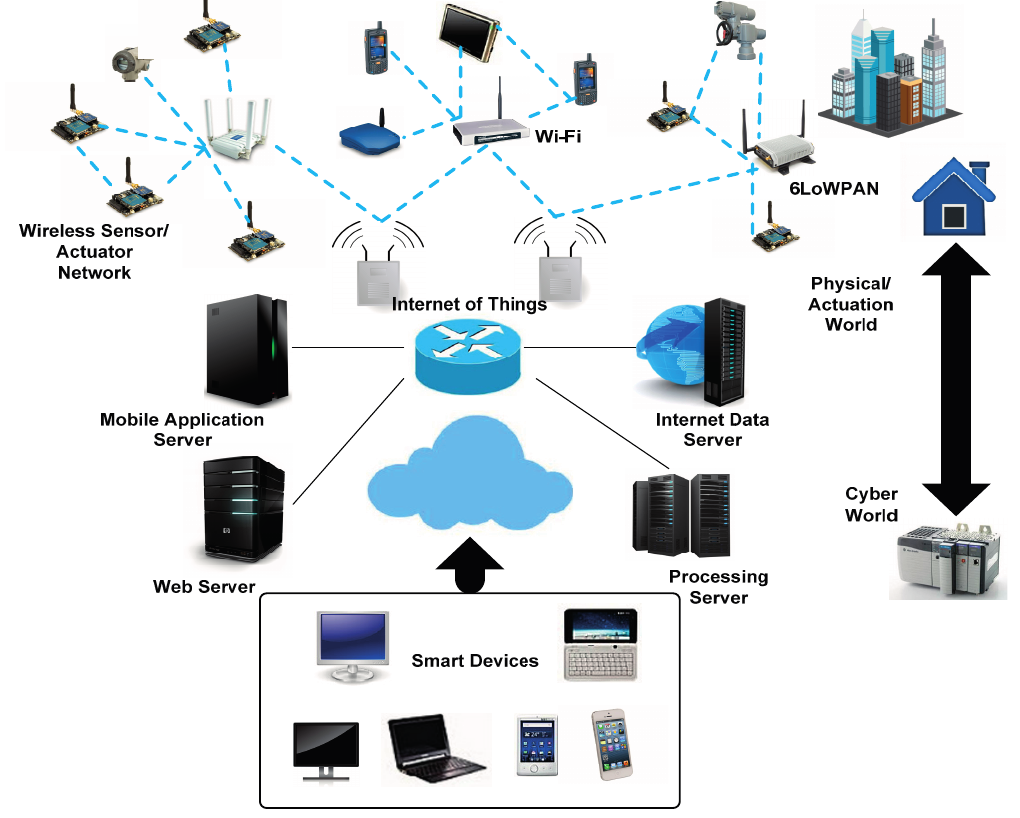
Figure 1. Network elements in CPS